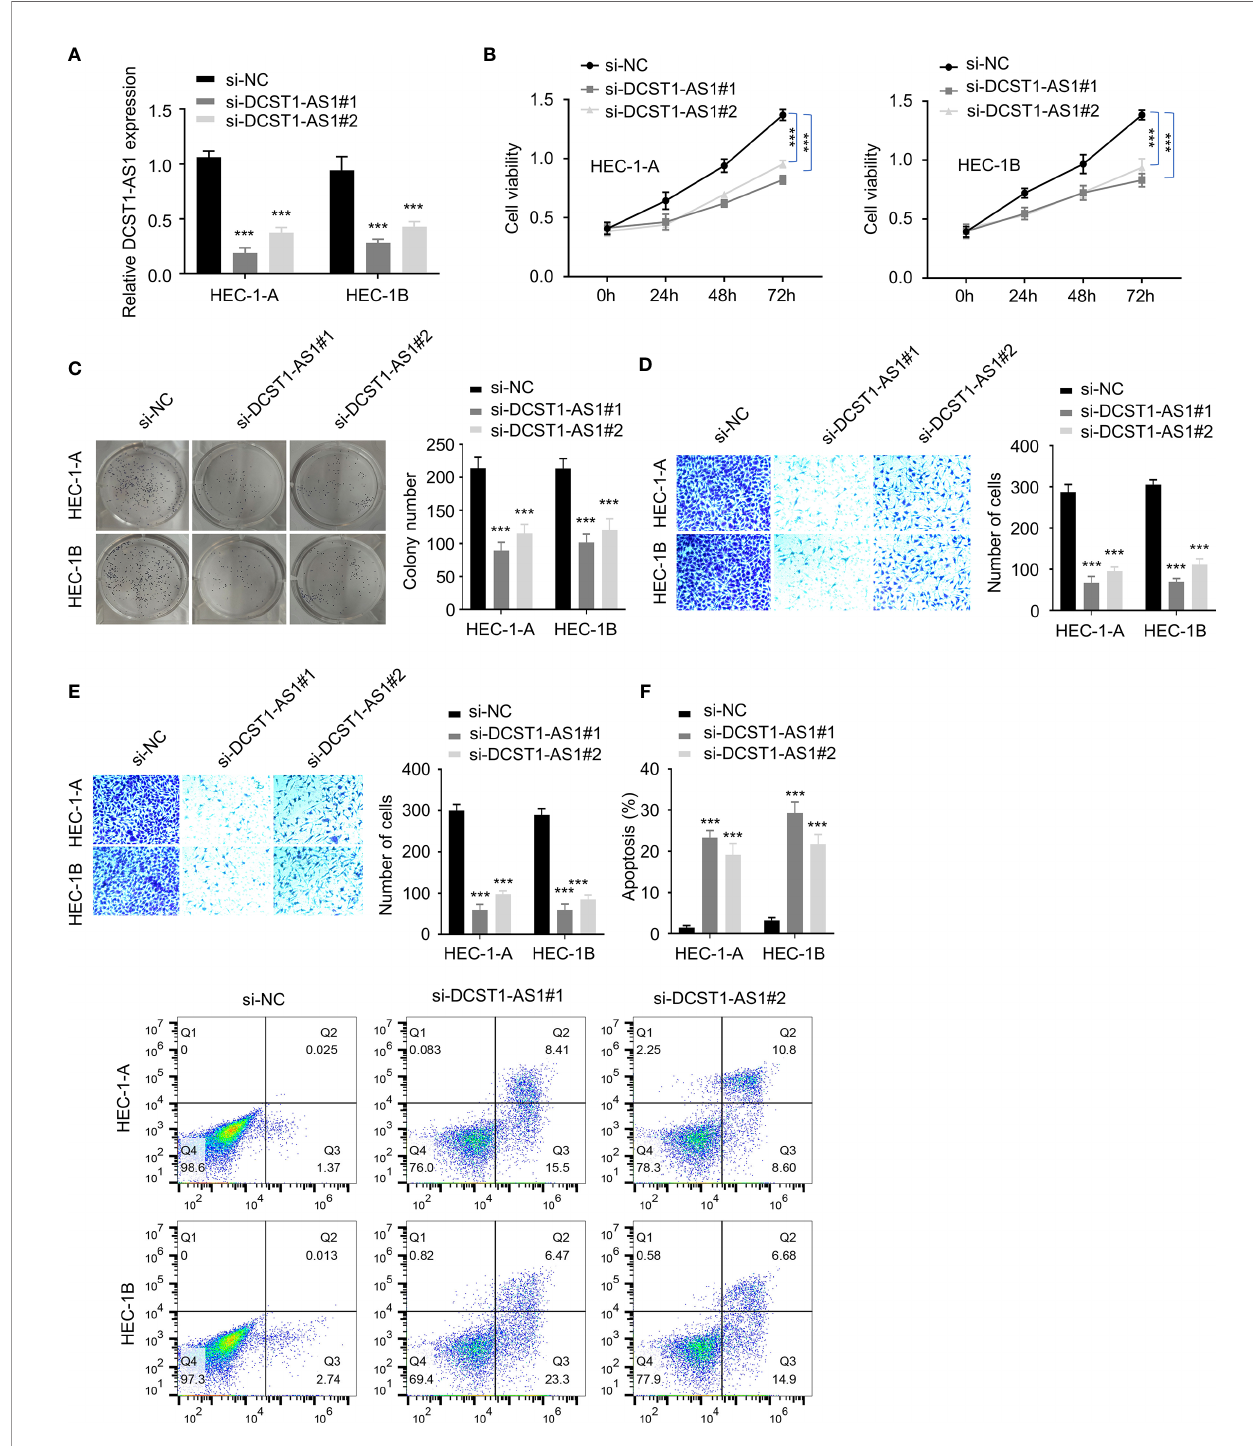
FIGURE 2 | Depletion of lncRNA DCST1-AS1 inhibits EC cell proliferation, migration, and invasion. (A) The expression of lncRNA DCST1-AS1 was measured by RT-qPCR assay in HEC-1A and HEC-1B cells transfected with DCST1-AS1 siRNA (si-DCST1-AS1) or control siRNA (si-NC). (B) Cell Counting Kit-8 (CCK-8) assay showed that depletion of DCST1-AS1 suppressed EC cell proliferation. (C) Colony formation assay of EC cells transfected with si-NC or si-DCST1-AS1. (D, E) Transwell migration and invasion assay showed that DCST1-AS1 knockdown inhibited EC cell migration (D) and invasion (E) . (F) Flow cytometry assay showed that DCST1-AS1 knockdown increased EC cell apoptosis. *** P <